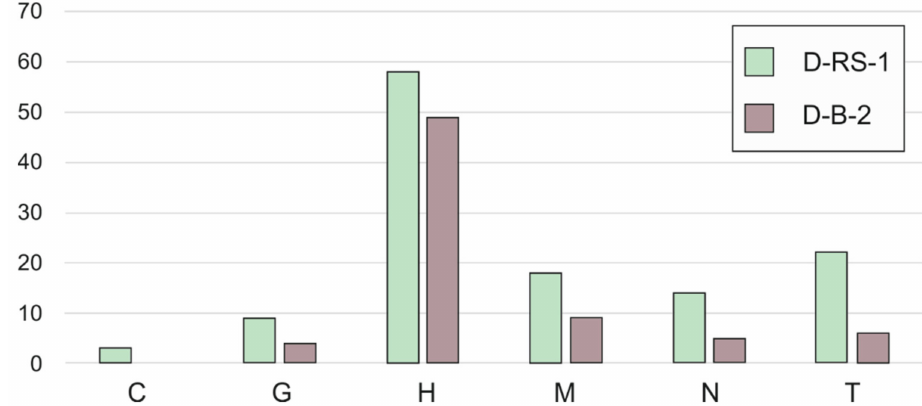
Figure 12. The species number contributions of Raunkiær’s lifeforms: C: woody chamaephytes, G: geophytes, H: hemicryp- tophytes, M: megaphanerophytes, N: nanophanerophytes, and T: